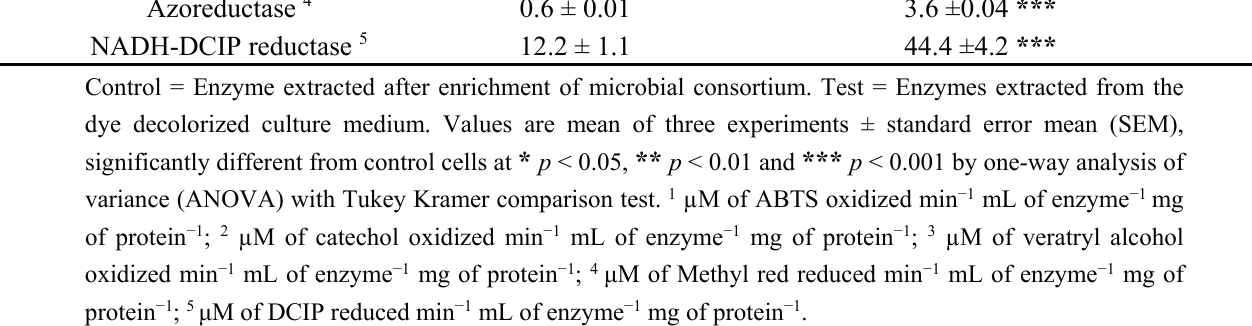
Table 3. Enzyme activities in control cells and cells obtained after decolorization of dye Trypan Blue (50 mg·L − 1 ) by microbial consortium.